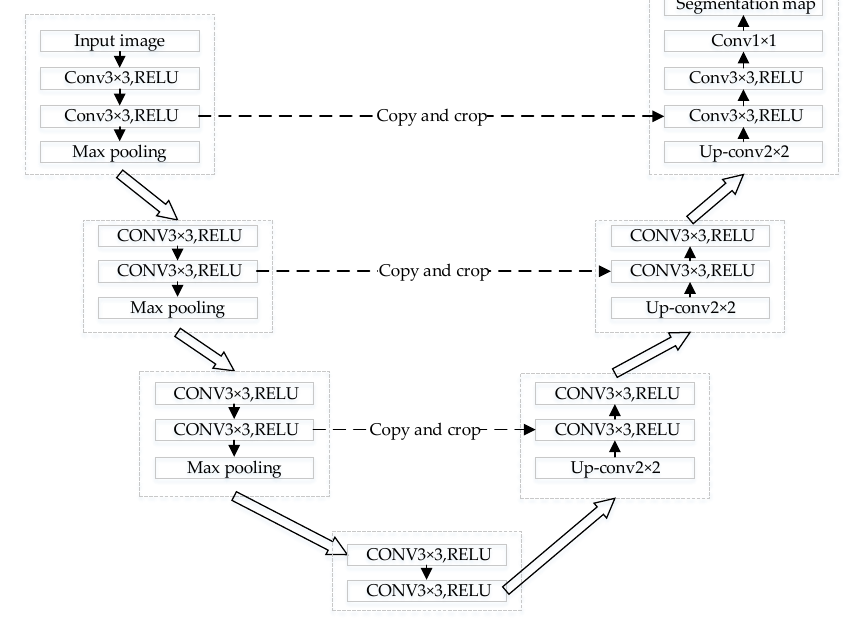
Figure 2. U-net architecture.